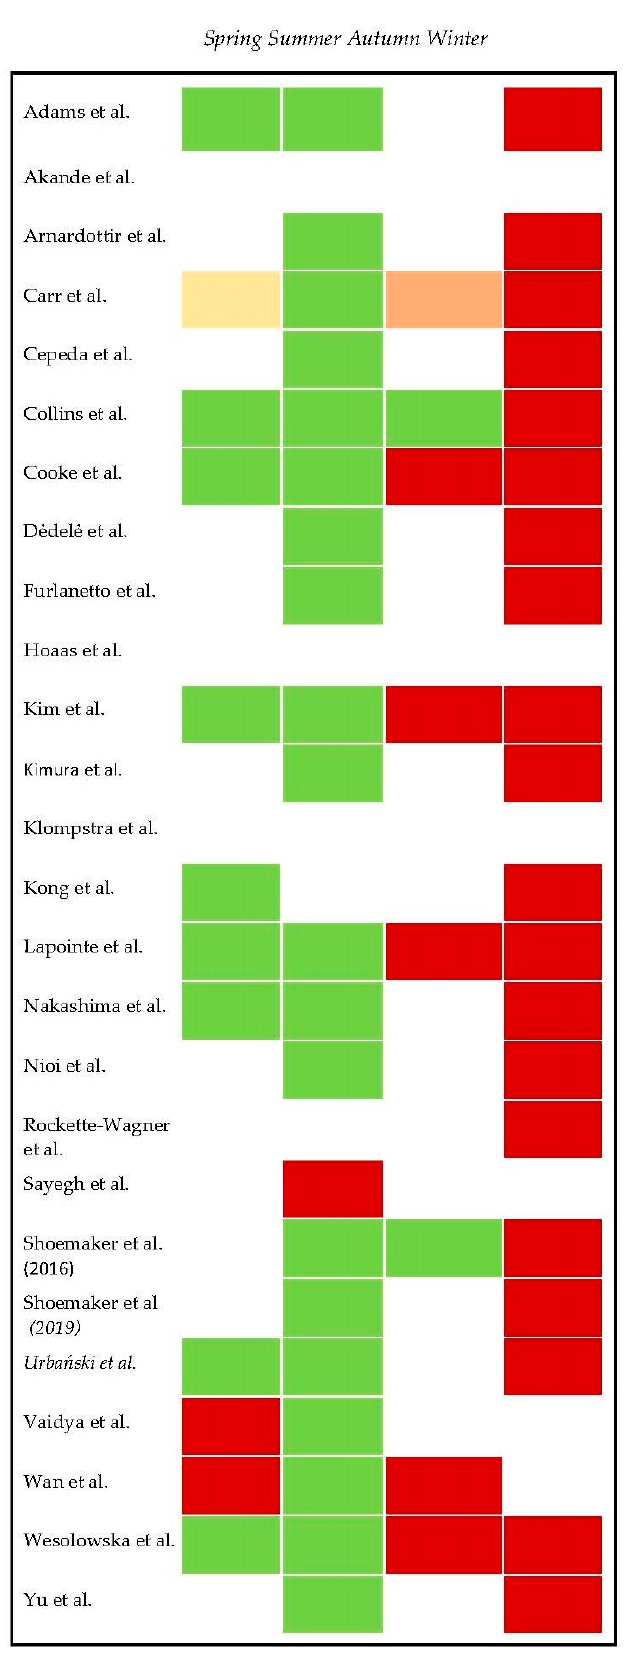
Figure 2. Statistically significant variations of physical activity (PA) according to seasons (green color for highest PA and red for lowest PA in each